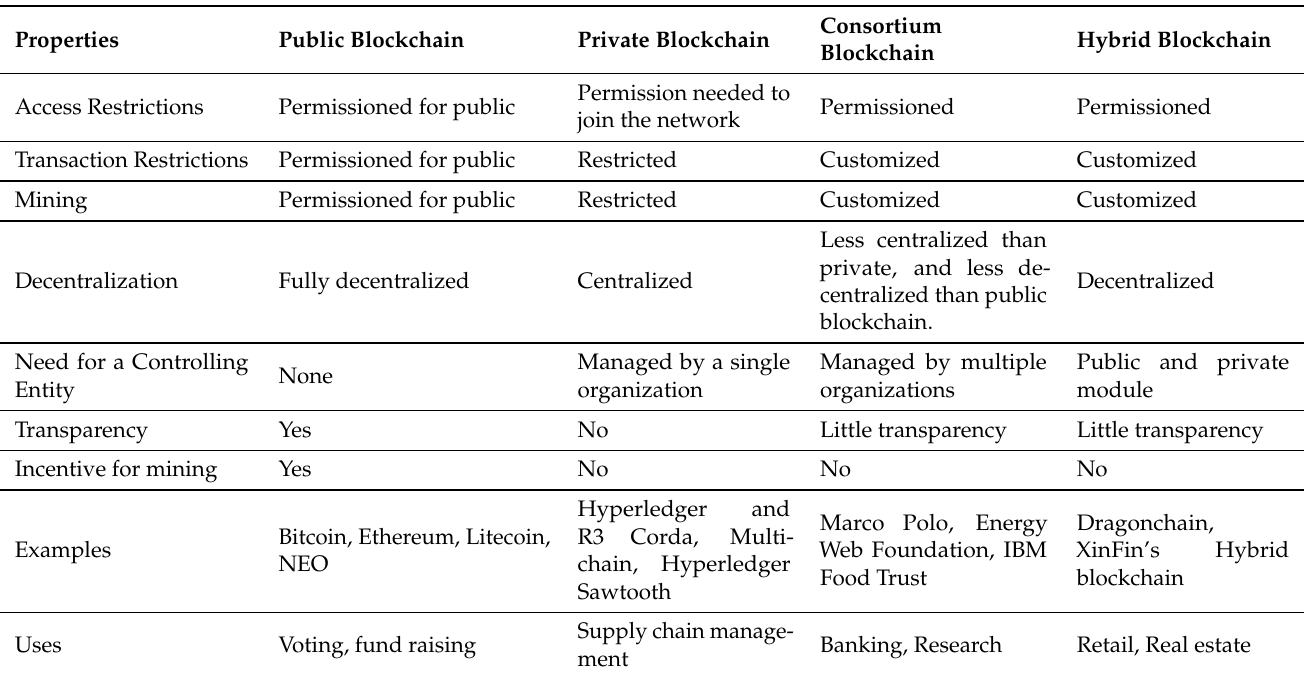
Figure 4. Structure of Blockchain. Table 4. Types of blockchain and their